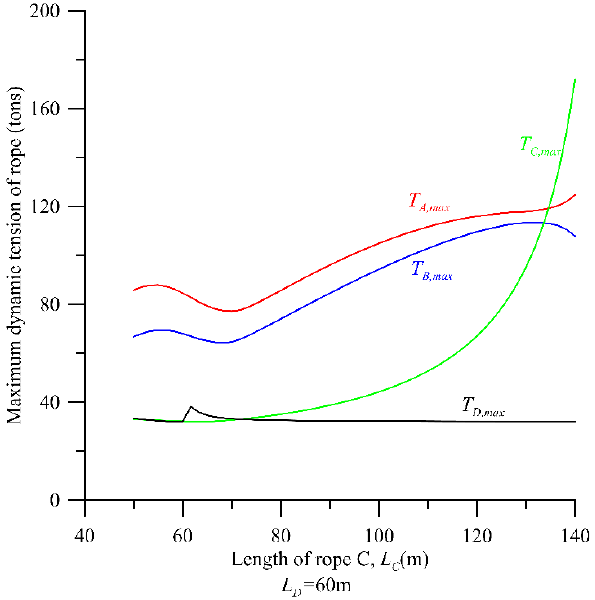
Figure 16. Effect of length of rope C on the dynamic tension ( β P = β T = 1).